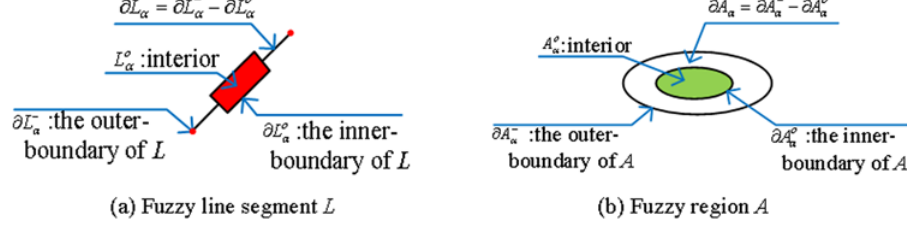
Fig 3. (a) The inner-outer boundary of simple fuzzy line segment L for given α ; (b) the inner-outer boundary of simple fuzzy region A for given α